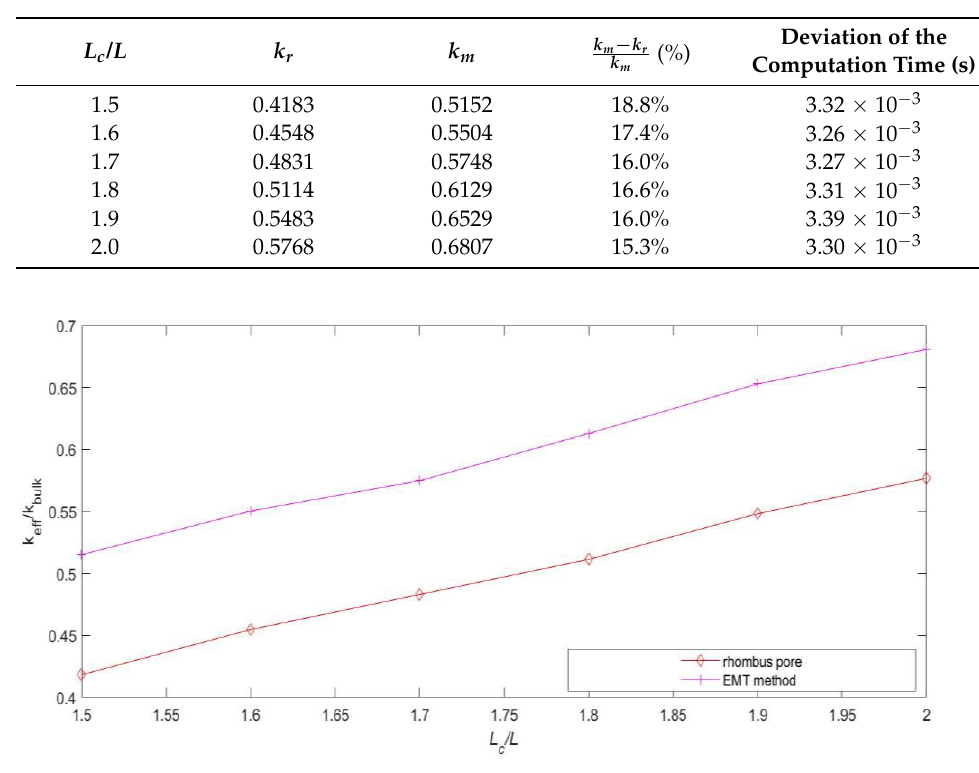
Figure 9. The effective thermal conductivity with the EMT method and the MCBU method in